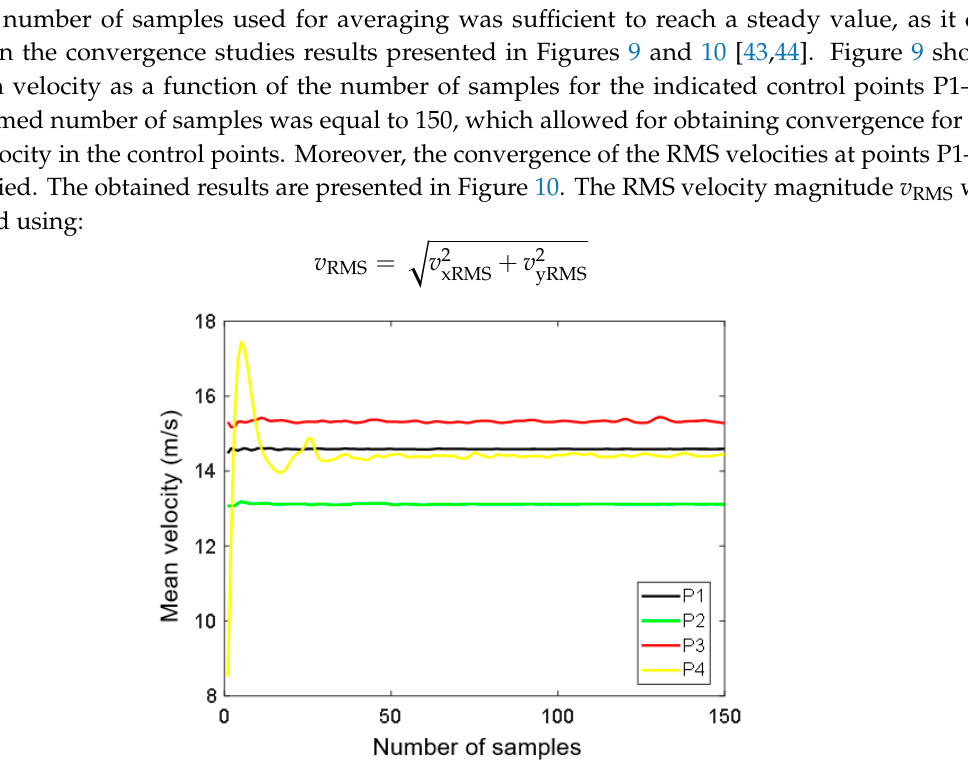
Figure 9. Convergence for increasing numbers of vector fields of the mean velocity at the control points.